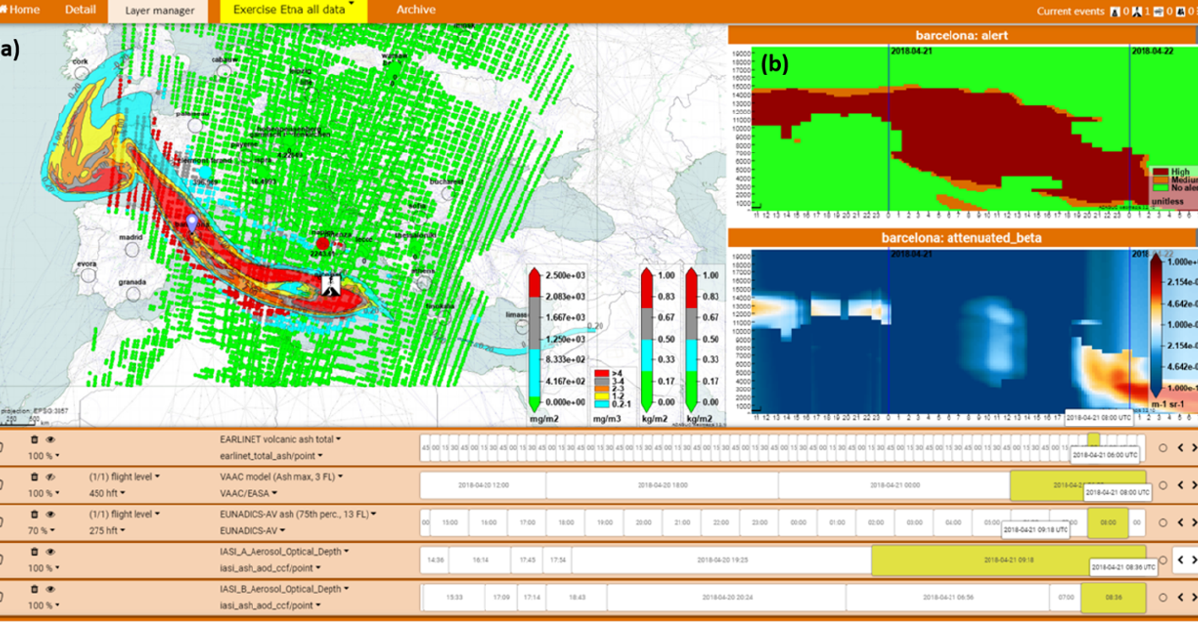
Figure 5. Exemplified visualization of the EUNADICS-AV portal showing the model ensemble (a) and the vertical ash distribution (b) at an ACTRIS EARLINET station (Barcelona) on 21 April 2018.